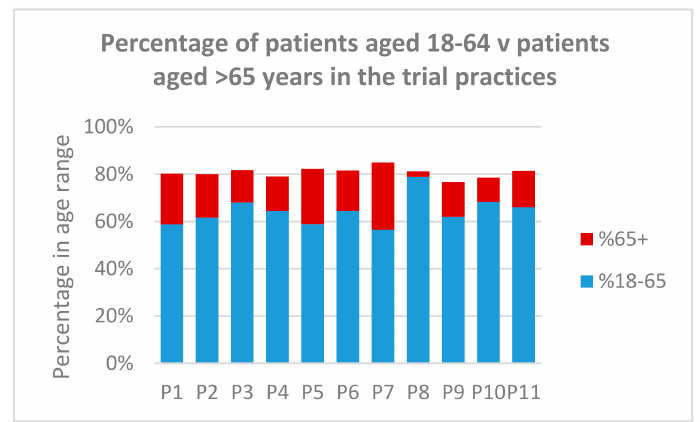
Figure 5. Comparison of the percentage of patients aged 18–64 with those aged over 65